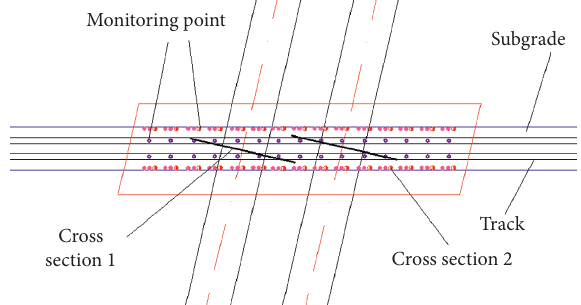
Figure 4: Monitoring site layout.